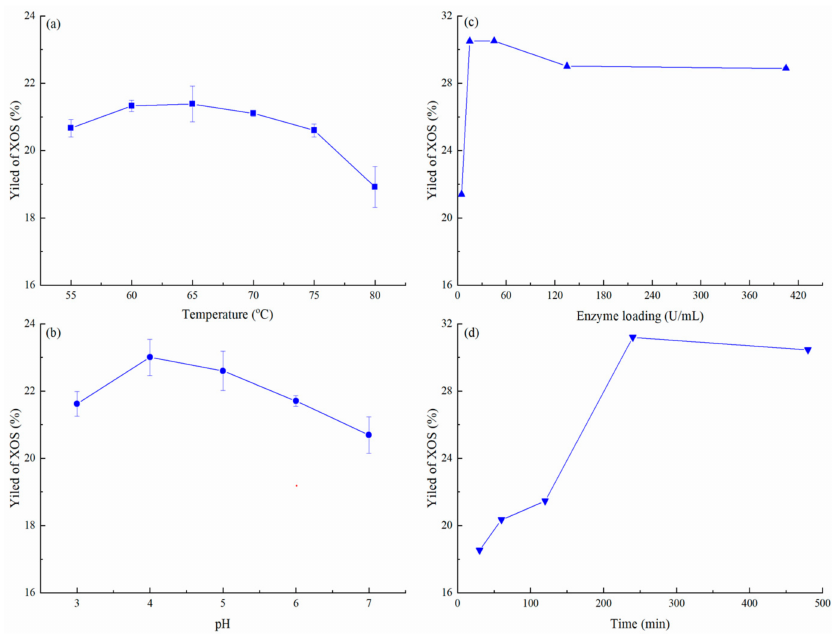
Figure 6. Effect of temperature ( a ), pH ( b ), enzyme loading ( c ) and time ( d ) on XOS production. The pH is another important factor affecting the enzymatic hydrolysis of